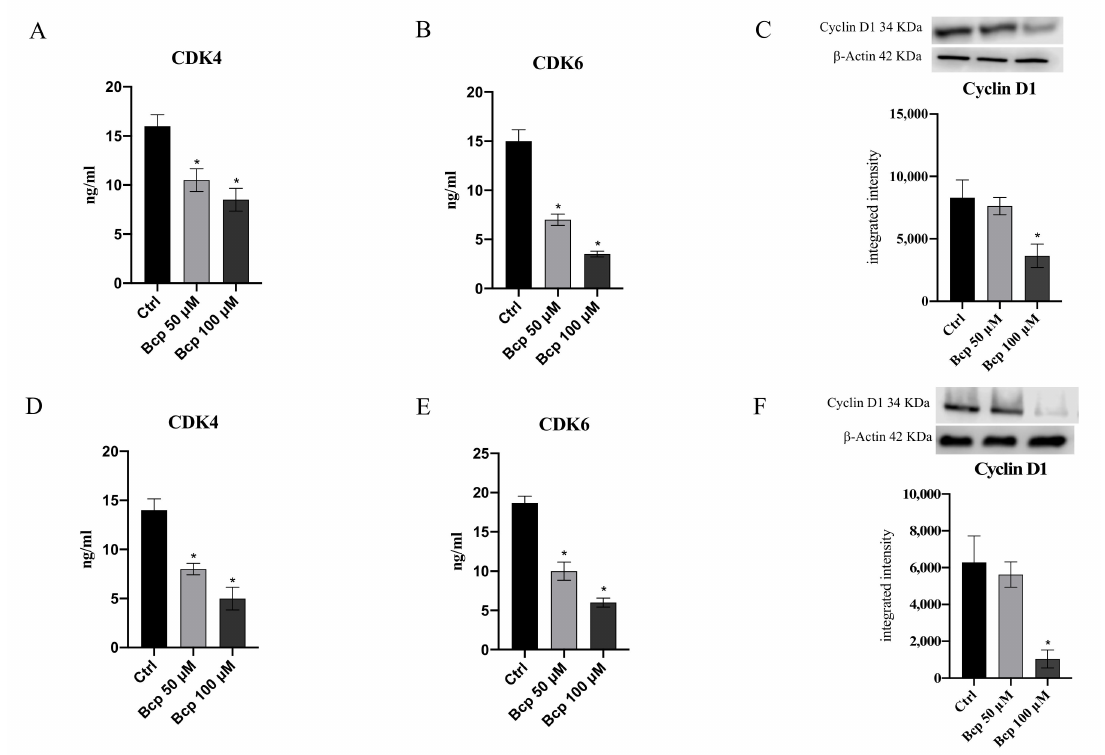
Figure 7. The graphs represent CDK4 ( A ), CDK6 ( B ), and cyclin D1 ( C ) protein levels in MM.1S cells. CDK4 ( D ), CDK6 ( E ), and cyclin D1 ( F ) protein levels in MM.1R cells treated with BCP. The data are expressed as means ± SEM; n = 3 experiments; * p < 0.05 vs.